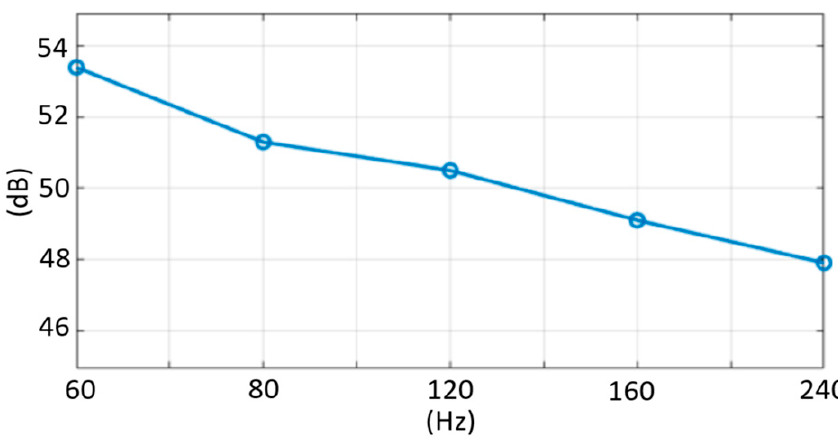
Figure 22. Measured SNR versus scan rate.